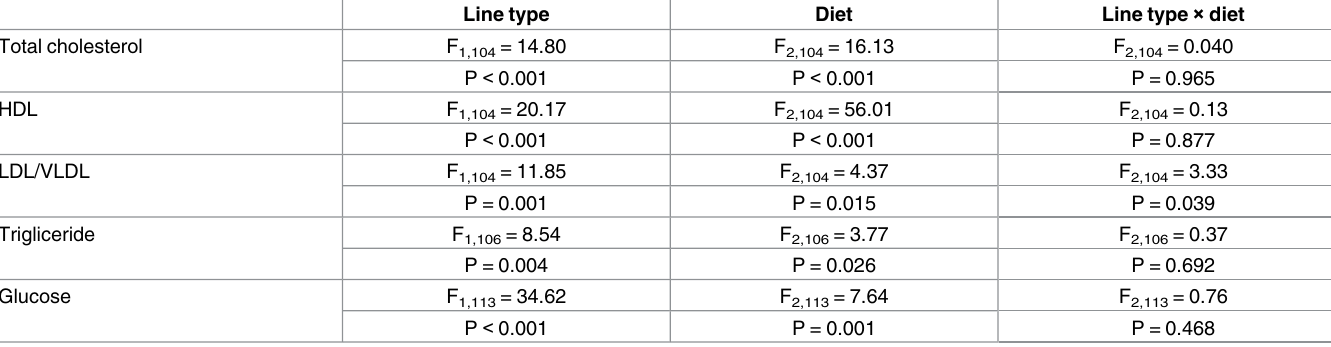
Table 4. ANOVA results of lipid profile and blood glucose of H-BMR and L-BMR type mice fed a HCarb, HFat and Control